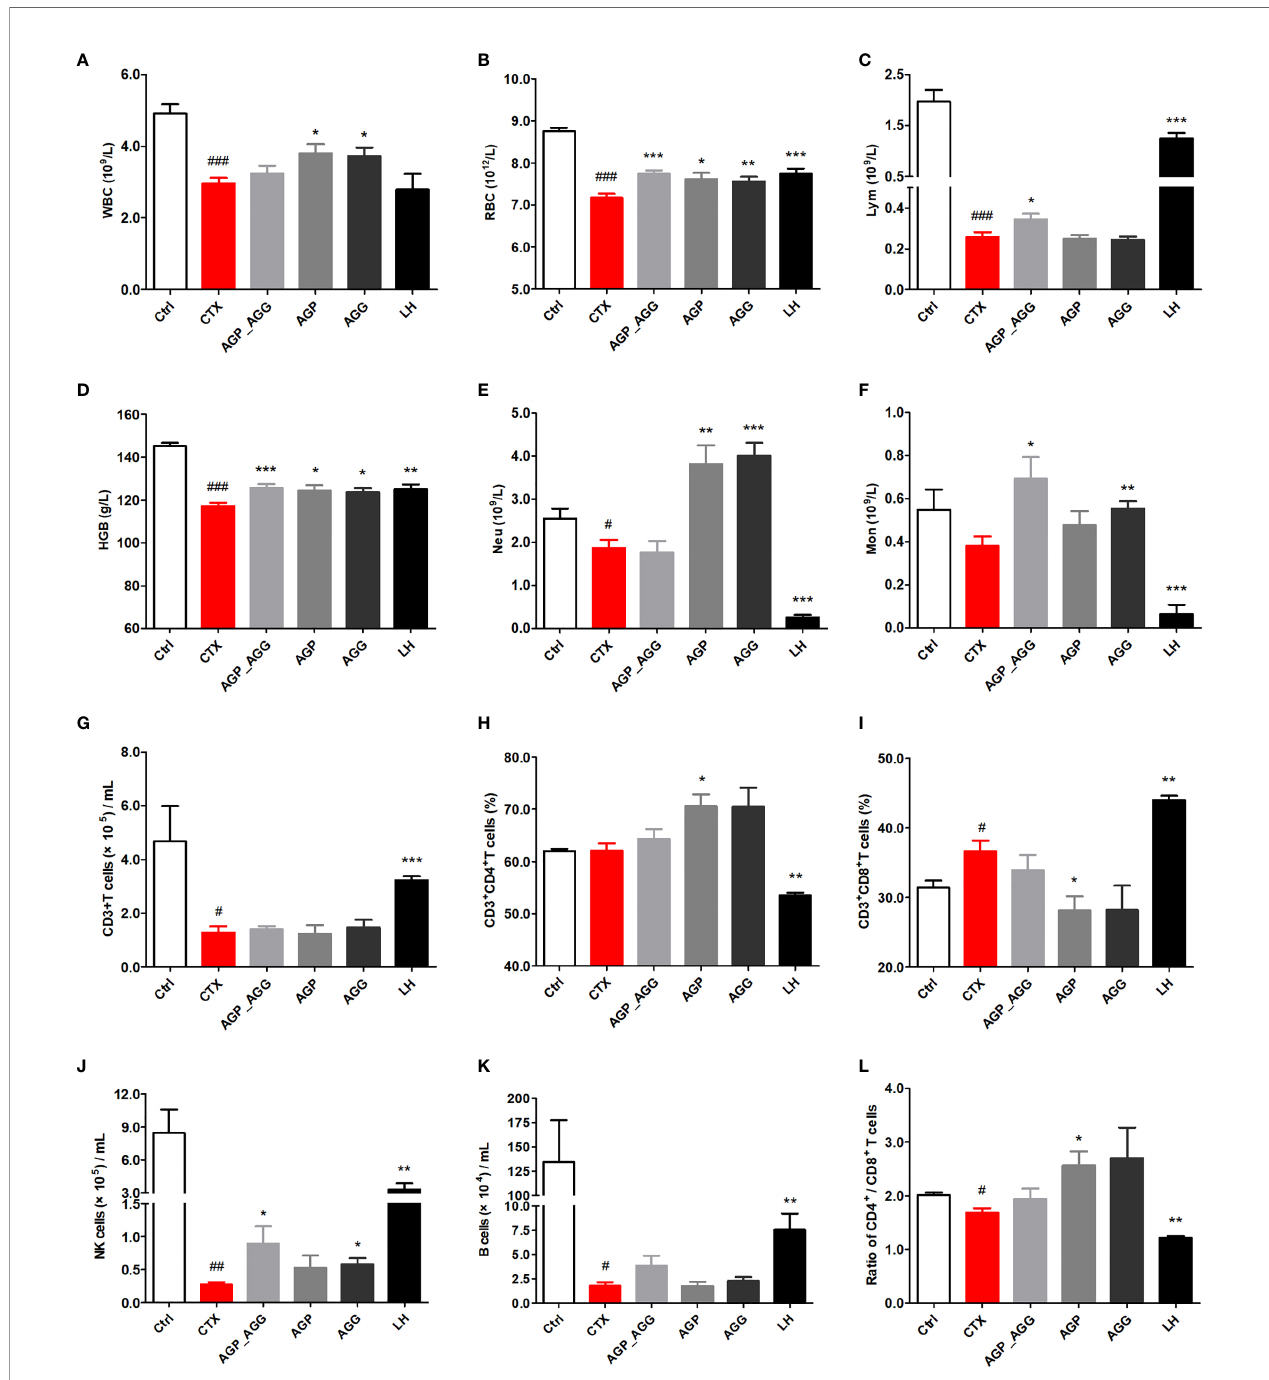
FIGURE 1 | AG treatments adjusted hematological indices in CTX-induced immunosuppression mice. (n=7 for each group). (A) WBC. (B) RBC. (C) Lym. (D) HGB. (E) Neu. (F) Mon. (G) The quantity of CD3 + T cells. (H) The percentage of CD3 + CD4 + T cells. (I) The percentage of CD3 + CD8 + T cells. (J) The quantity of NK cells. (K) The quantity of B cells. (L) The ratio of splenic CD4 + /CD8 + T cells. Data are expressed as mean with SD. # P < 0.05, ## P < 0.01, ### P < 0.001 compared with Ctrl;* P < 0.05, ** P < 0.01, *** P < 0.001 compared with CTX by student t test. Ctrl, control group; CTX, cyclophosphamide-induced immunosuppressive group; AGP_AGG, American ginseng polysaccharide+American ginseng ginsenoside with cyclophosphamide-induced immunosuppressive group; AGP, American ginseng polysaccharide with cyclophosphamide-induced immunosuppressive group; AGG, American ginseng ginsenoside with cyclophosphamide-induced immunosuppressive